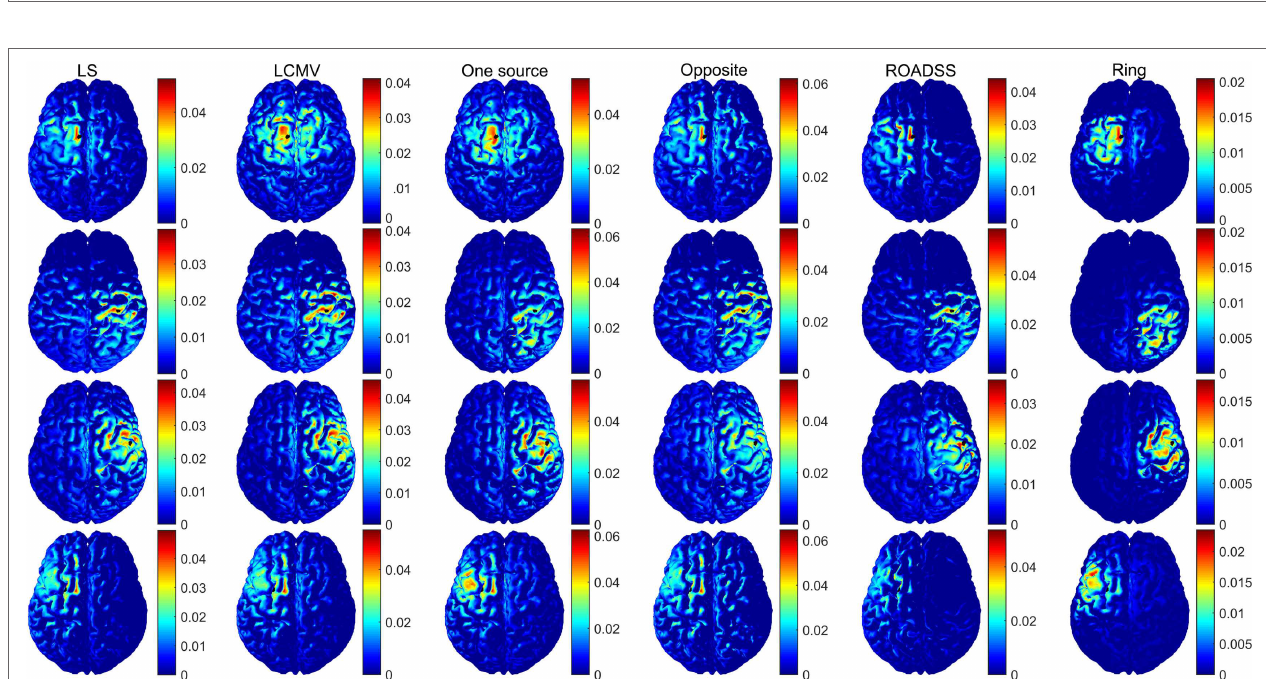
FIGURE 10 | Normal to cortex component of the current density (ampere/square meter) for the 256 EGI electrode net . Rows from top to bottom correspond to optimal stimulation of targets T1, T2, T3, and T4; columns correspond to the optimal current injection patterns obtained, from left to right, with the LS, LCMV, “one source,” “opposite,” “ROADSS,” and “ring” methods. The total current injected in each case is 1mA. The cortical ROIs to target are shown in